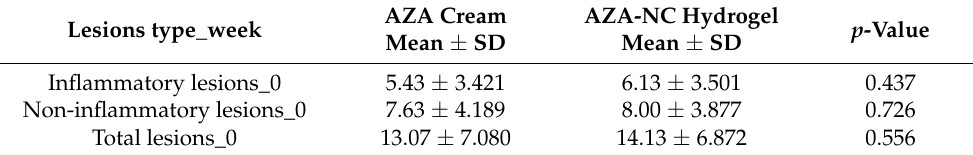
Table 3. The mean number of lesions at baseline in all